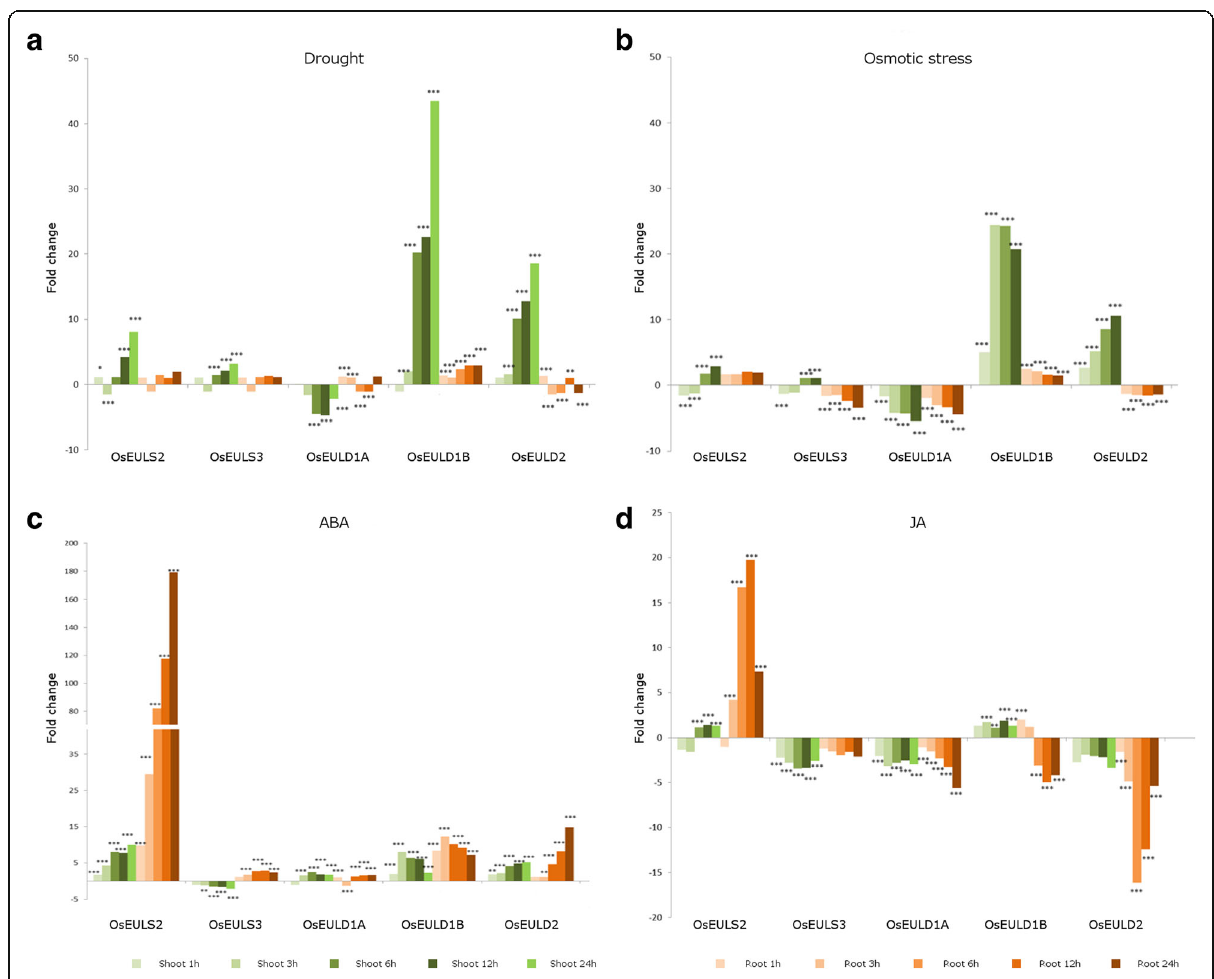
Fig. 5 Expression profiles of the rice EUL genes upon plant stress represented as fold change. The false discovery rate is represented with asterisks to denote statistical significance. One star (*) is used if the value is less than 0.05, two stars (**) represent values less than 0.05 but higher or equal to 0.001, and three stars (***) show a value below 0.001. a . Drought stress. b . Osmotic stress. c . ABA treatment. d . JA